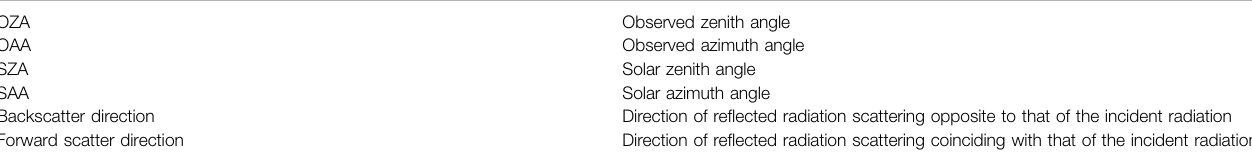
TABLE 1 | De fi nition of terms used to describe the geometry of the measurements. OZA